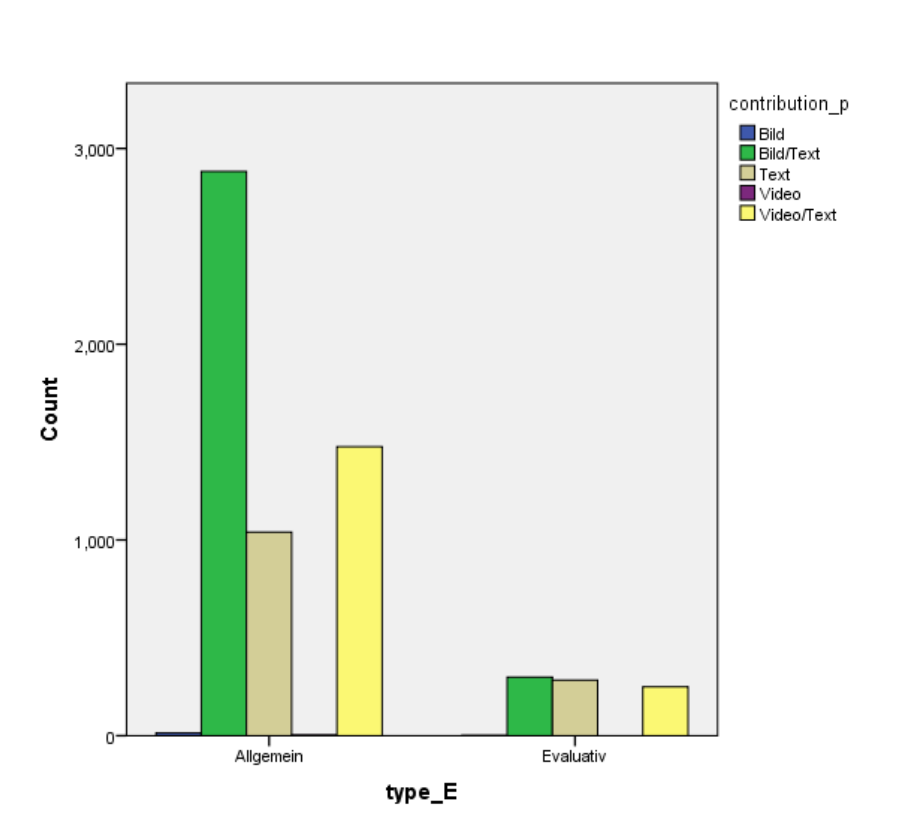
Figure 4. Number of Posts tagged with Image/Image Text/Text/Video - Splitted into Regular and